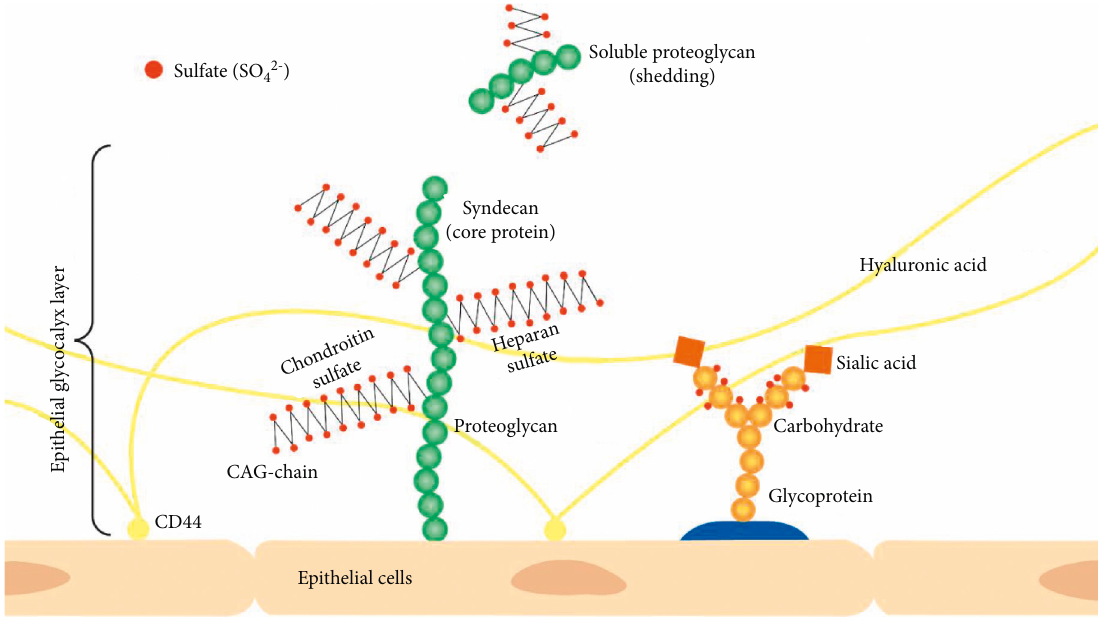
Figure 1: Schematic presentation of the epithelial glycocalyx (GL) in mammalian cells, forming a mesh-like structure that projects into the extracellular matrix (ECM). The proteoglycan presented is a syndecan with heparan sulfate and chondroitin sulfate glycosaminoglycan (GAG) side chains. The sulfate groups (SO 42 − ) are indicated in red dots, attached to the GAG and glycoprotein side chains. Hyaluronic acid is unsulfated and anchored to the receptor CD44 on the cell membrane. The glycoprotein consists of a protein base with carbohydrate chains (orange circles) extending into the extracellular space with sialic acid (orange square) bound at the terminal position of the oligosaccharide chains. Soluble proteoglycans and free GAG chains can appear in the extracellular